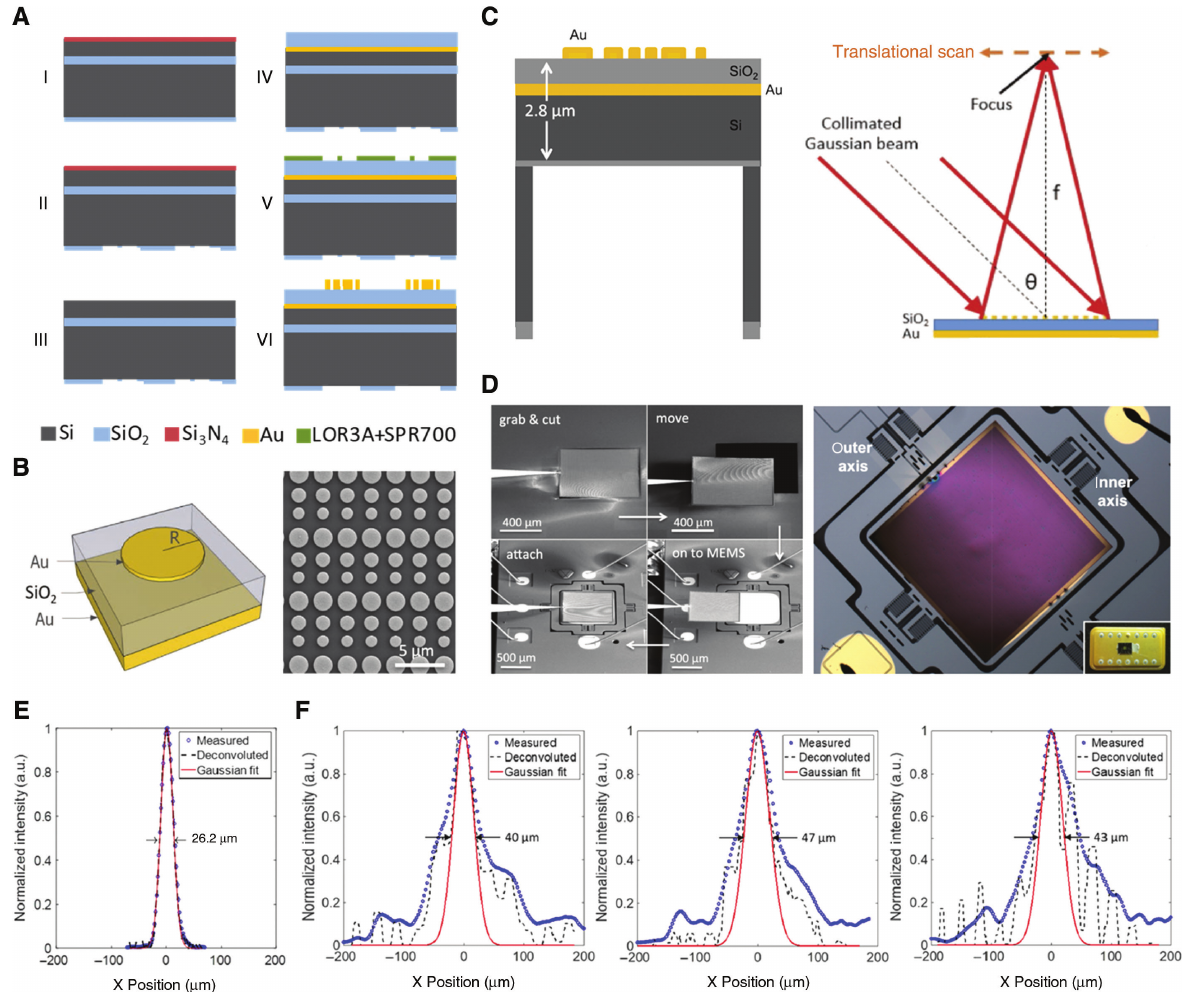
Figure 2: Metasurface-based devices working in mid-IR patterned using a stepper with 365 nm light source. (A) Fabrication process flow of the metallic metalens on Si wafer. The back-etch window is opened by patterning the SiO layer from the 2 bottom of the Si wafer. Then, two Au layers are grown on the substrate with a layer of SiO in between. The bottom Au layer acts as a 2 reflection layer, and the top Au layer is patterned as a metasurface layer. (B) Schematic of metasurface unit cell (left) and top-view SEM image of the patterned Au nanodisk (right). (C) Schematic of the cross-section of the fabricated metalens on Si membrane after back-side etching of the substrate (left) and schematic of the functional metasurface (right). (D) Steps to integrate the metalens from membrane onto the MEMS for tuning (left) and microscopy image of the metalens on MEMS stage, with two rotational axis indicated (right). (E) Translational scan measurement of the reflected laser beam at the focal line center. (F) Translational scan measurement of the reflected laser beam at the focal line center with MEMS rotation angles of 0 ° , 1 ° , and 2.5 ° (left, middle, and right, respectively). (A–F) Adapted with permission